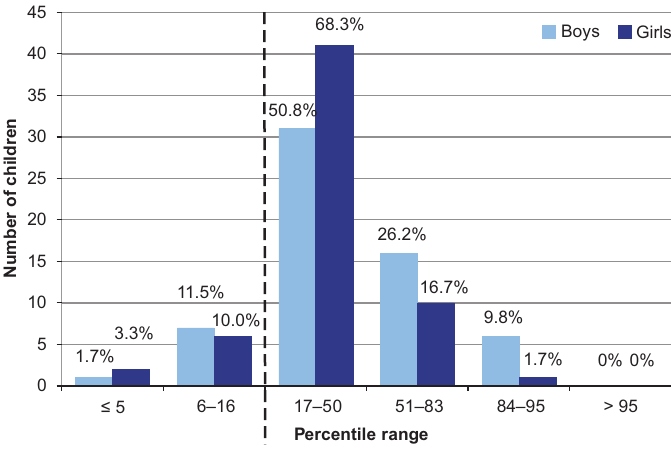
Figure 2. Distribution in relation to gender according to MABC-2 test norms (≤ 5 th percentile = significant motor difficul- ties, 6–16 th percentile = risk of motor difficulties, > 16 th percen- tile = no motor difficulties). The dashed line divides the children with and without any motor